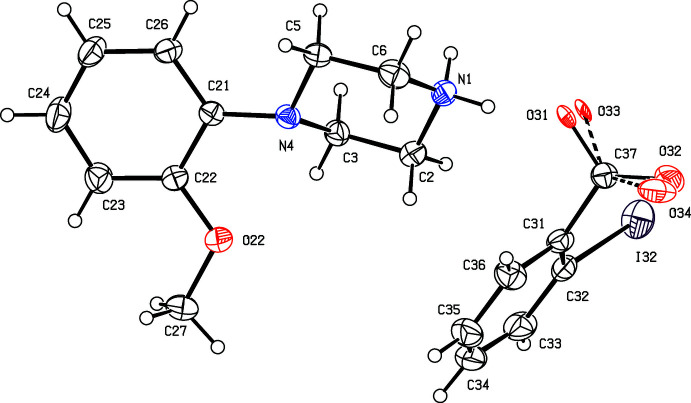
The independent components of compound (VII) showing the atom-labelling scheme and the disorder in the carboxyl­ate group; the major disorder component is drawn using full lines and the minor disorder component is drawn using broken lines. Displacement ellipsoids are drawn at the 30% probability level.